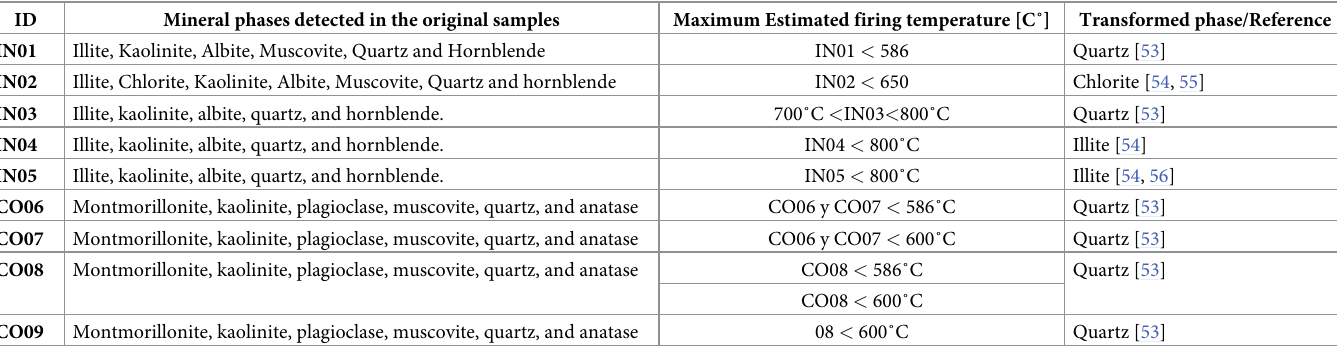
Table 8. Results by XRD and maximum estimated firing